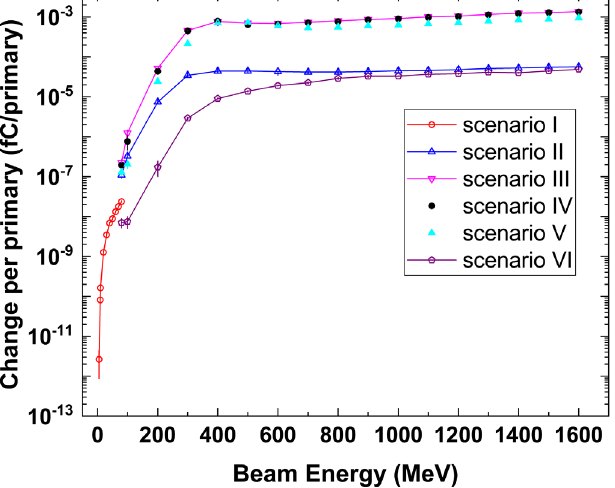
FIG. 18. BLM responses in the beam loss induced radiation field for the six loss